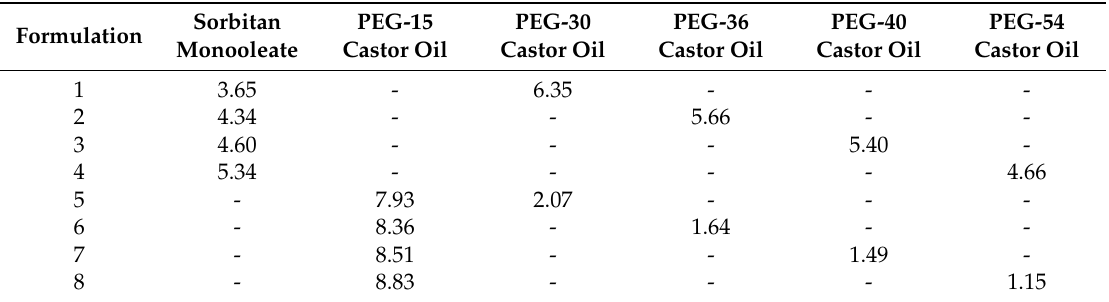
Table 1. Surfactant blend concentrations ( w / w %) to nanoemulsion preparation, maintaining constant the oil phase at 10.0 ( w / w %) and purified water at 80.0 ( w / w %). Sorbitan PEG-15 Formulation Monooleate